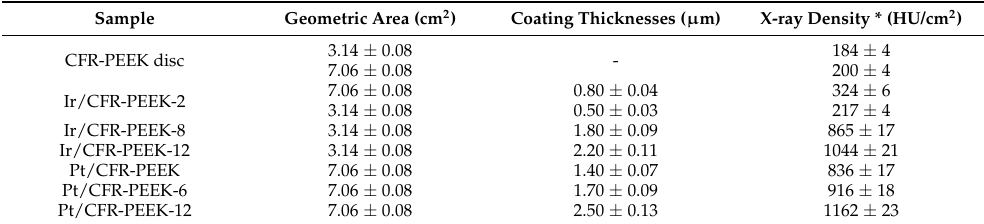
Table 2. X-ray density values of the series of Ir/CFR-PEEK and Pt/CFR-PEEK samples in comparison with CFR-PEEK discs. Sample